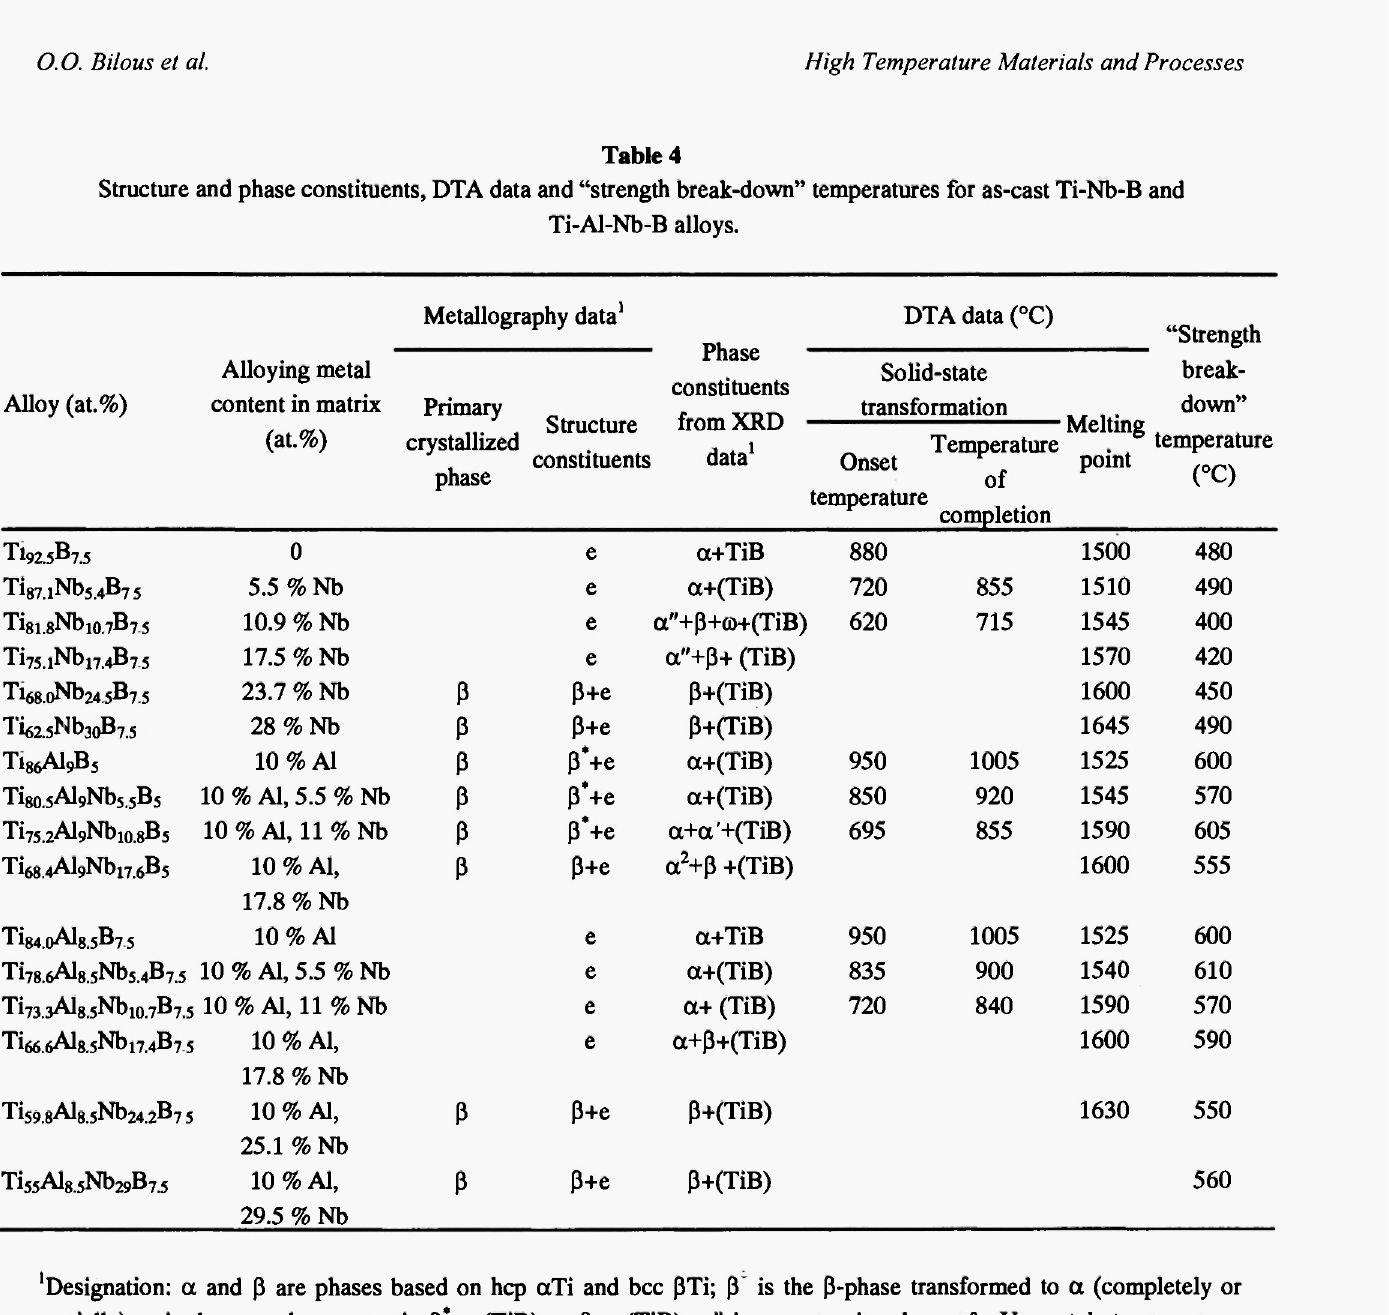
Structure and phase constituents, DTA data and "strength break-down" temperatures for as-cast Ti-Nb-B and Ti-Al-Nb-B